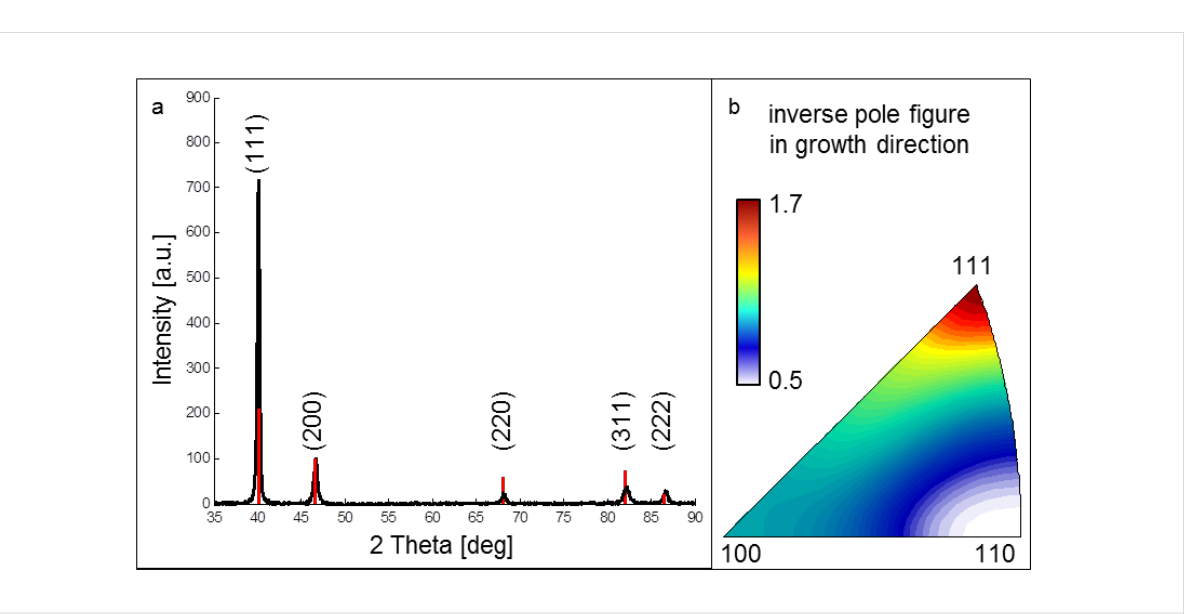
Figure 3: Orientation analysis of the as prepared sputtered ncPd film. a) X-ray diffraction pattern of the as deposited sample (black) (ncPd 2) overlaid with the isotropic Pd intensity profile (red) (normalized to the (200) peak intensity). b) Orientation density function (inverse pole figure) determined by ACOM-TEM in growth direction (ncPd